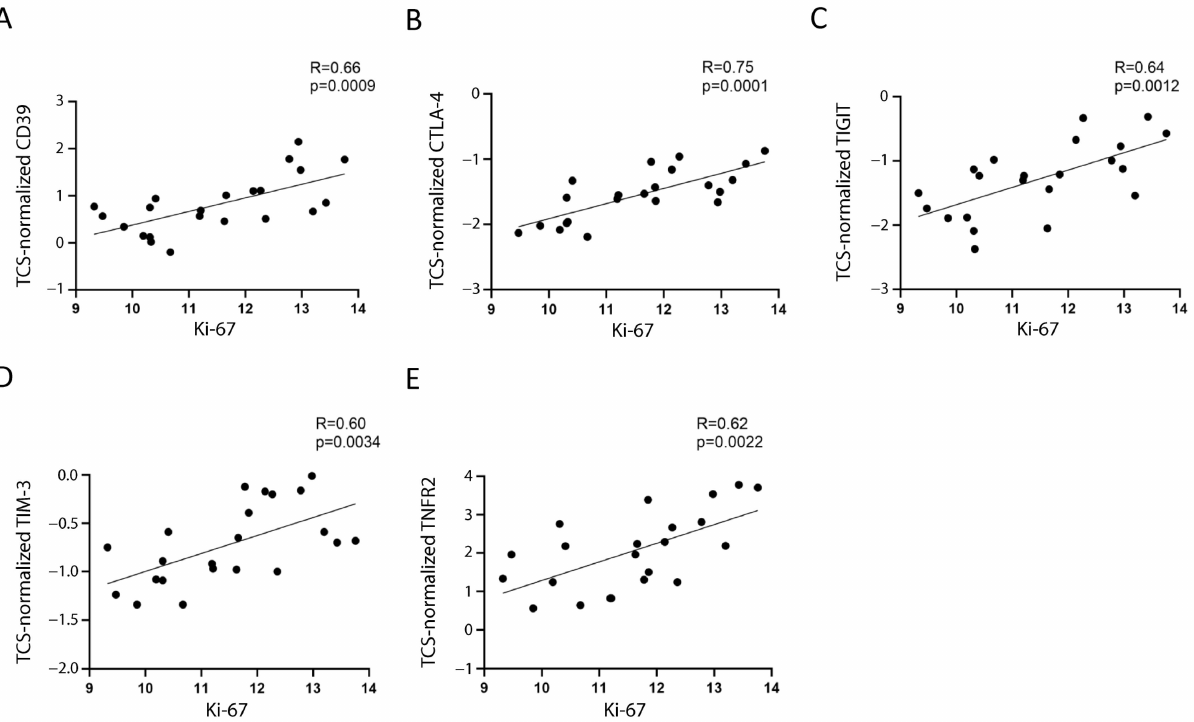
Figure 3. Correlation between Ki-67 and the selected markers . The correlation between mRNA expression of Ki-67 and normalized mRNA expression of CD39 ( A ), CTLA-4 ( B ), TIGIT ( C ), TIM-3 ( D ), and TNFR2 ( E ) is shown. The three values furthest from the line of regression were considered to be outliers and were deleted in each figure; the correlations including the outliers are shown in Figure S2. The rho factor of correlation (R) and significance evaluated using Pearson and Spearman tests are